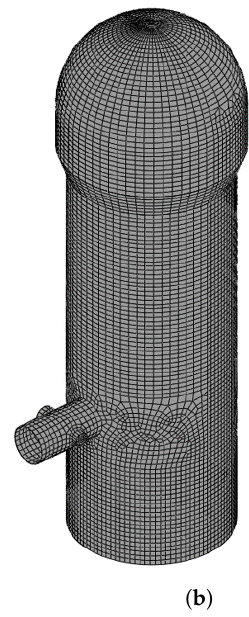
Figure 7. Meshes used for the ( a ) CFD and ( b ) FE